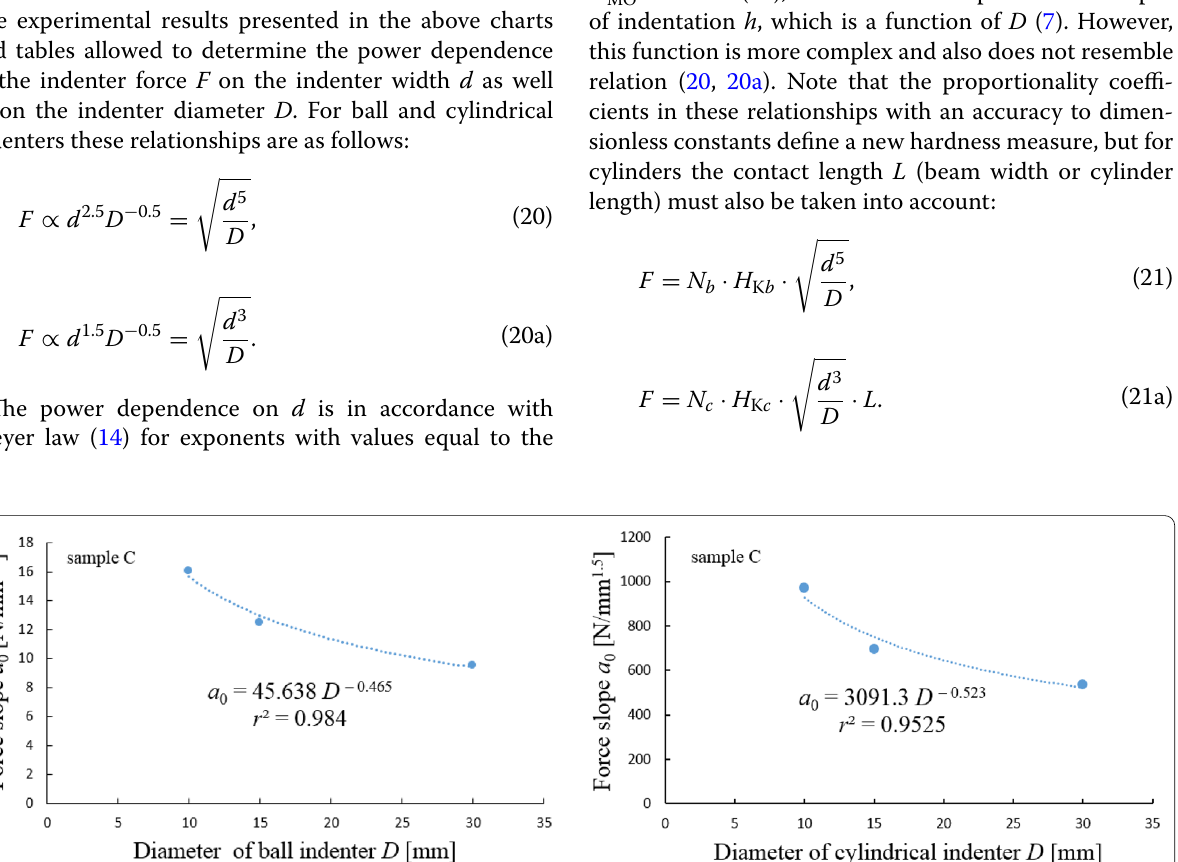
Fig. 7 Charts of the relation between proportionality coefficient a 0 of indenter force (in relation to the size of the indentation) and the diameter D of the indenter. Chart on the left refers for ball indenters, and on the right for cylindrical indenters on sample C